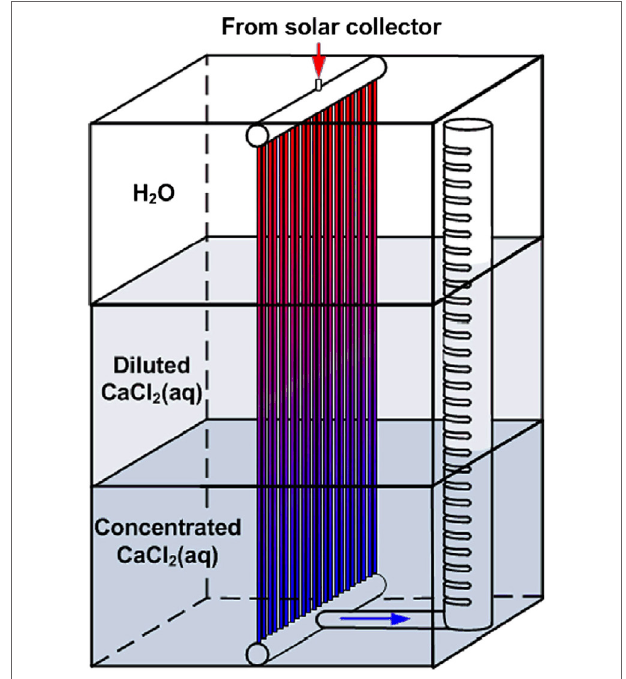
FigURe 9 | Advancements in absorption process used in thermal energy storage: integrated single-tank design. [Adapted from Quinnell and